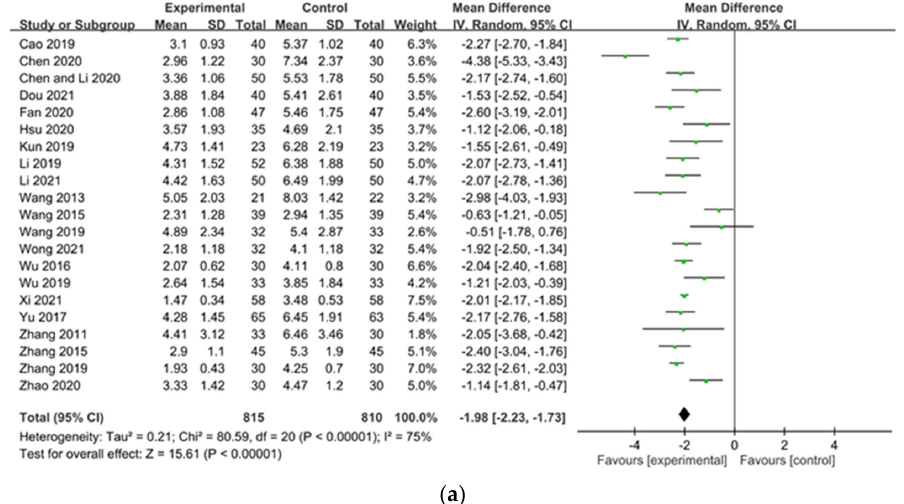
Figure 2. Risk of bias summary (“+” = low risk of bias, “ − “ = high risk of bias, “?” = unclear risk of bias).